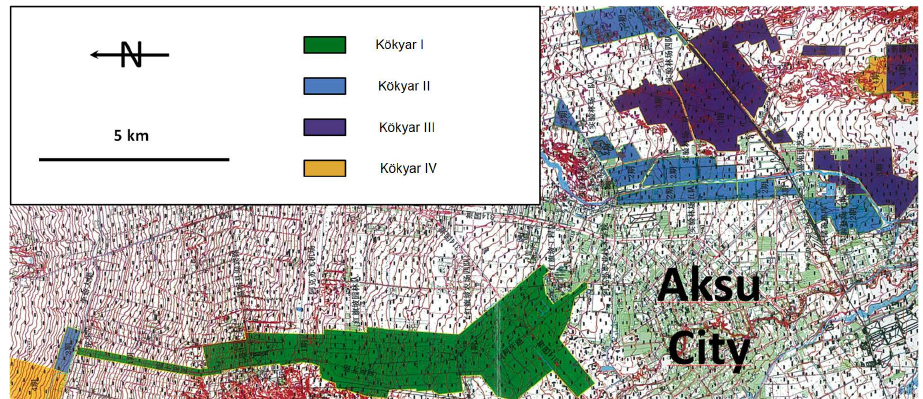
Figure 3. The areas of Kökyar I to IV consist of scattered patches surrounding Aksu City from north and east. Adapted from